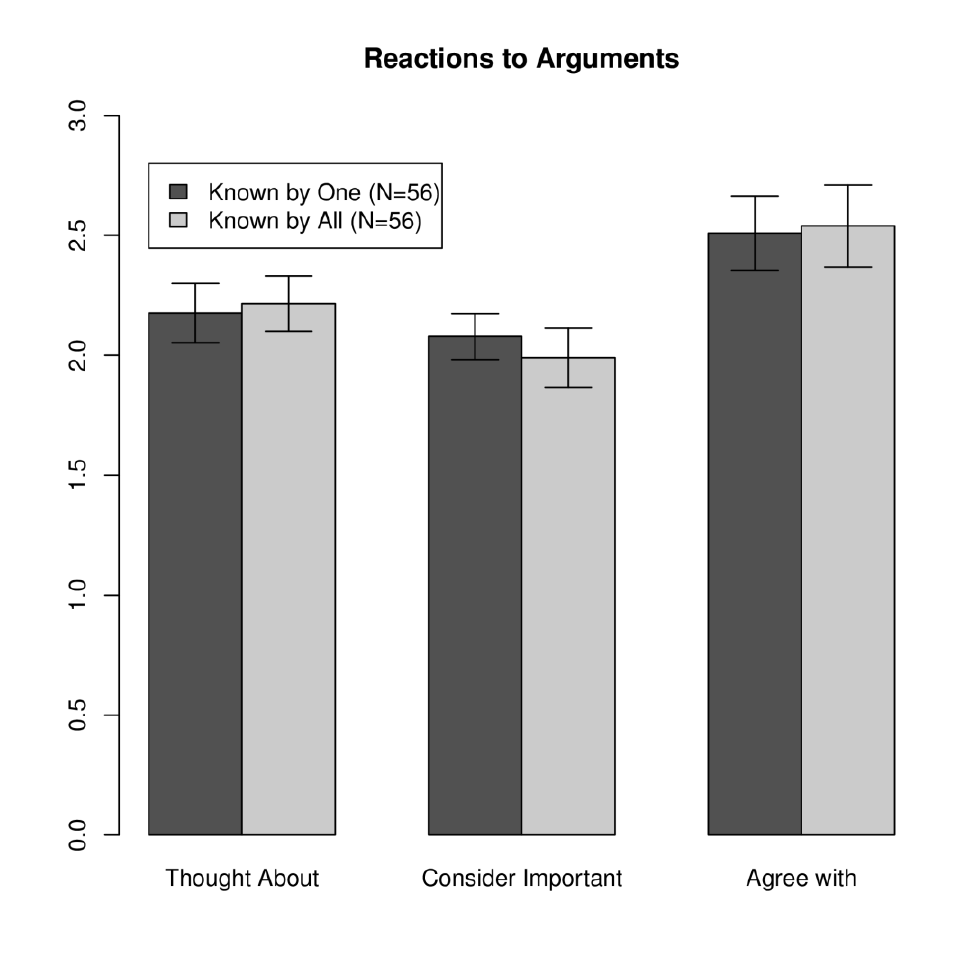
Figure 2: Post-Discussion Reactions to Common and Uncommon